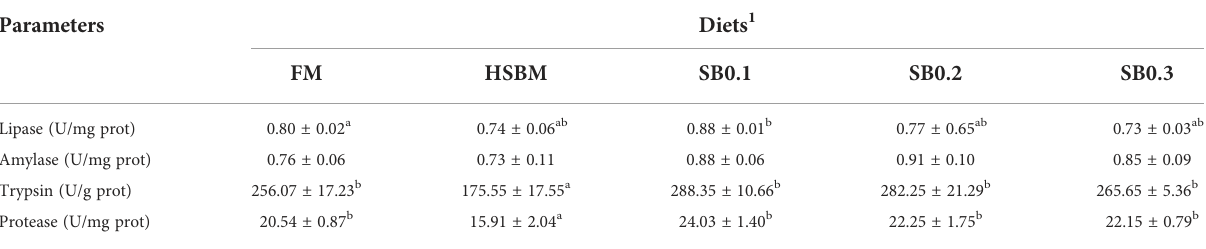
TABLE 5 Effects of sodium butyrate (SB) addition in high soybean meal (SBM) diets on activities of gut digestive enzymes of groupers in a 56-d feed period. Parameters